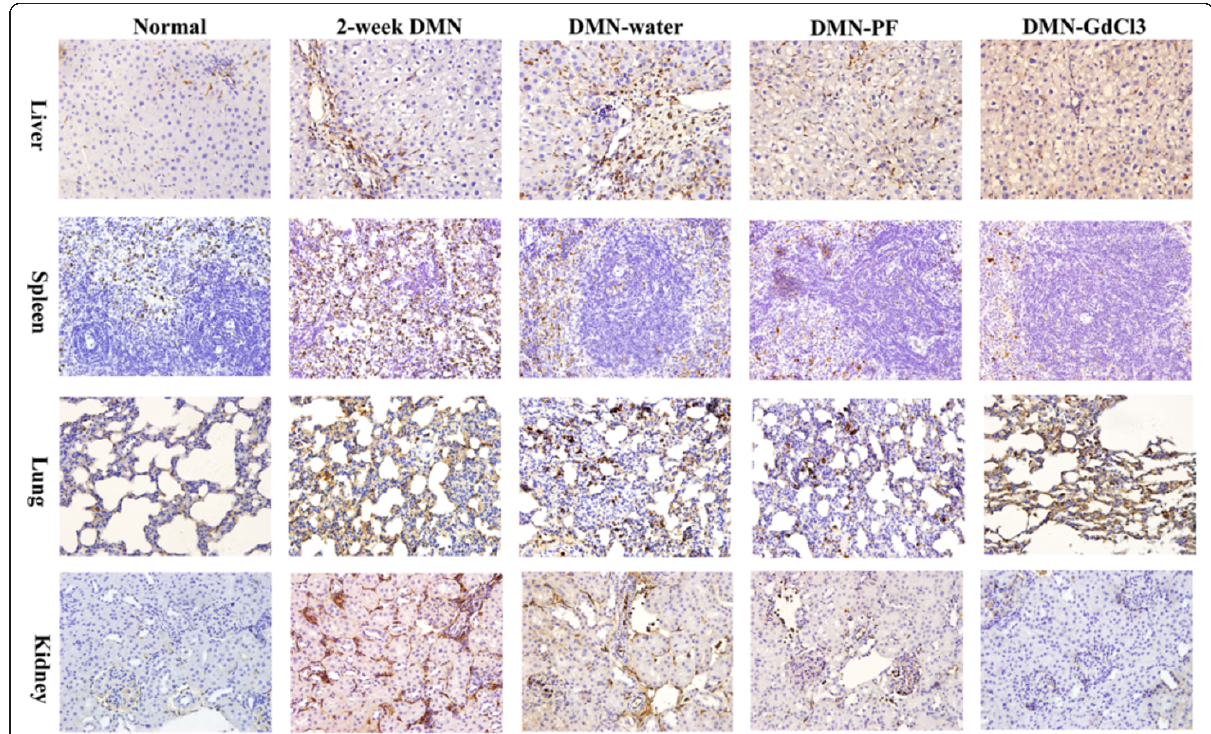
Figure 3 Effects of PF on CD68 using immunohistological staining in different organs in DMN-induced rat liver fibrosis. CD68 was investigated by brown staining indicates immunopositivity ×400 magnification,